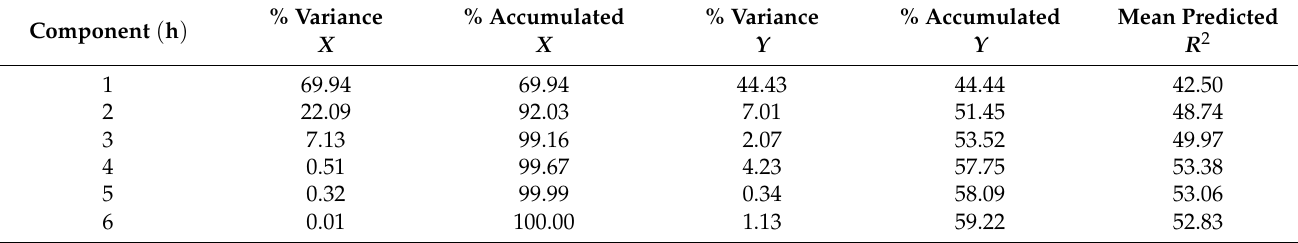
Table 3. Capability of explanatory ( X ) and response variables ( Y ) of VBT, VT, VR, VO, PBT, PT, PR and PO associations to capture % of variance depending on the number of components. Predictive potential expressed as R 2